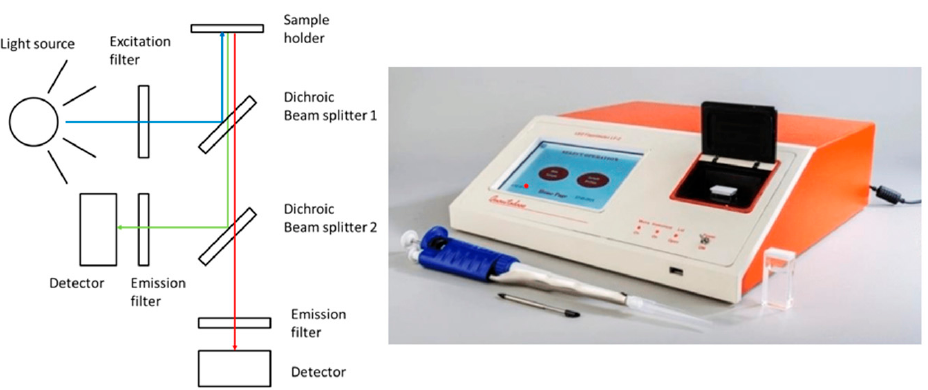
Figure 14. Schematic diagram depicting the working principle and a photo of commercial LED fluorimeter, modified from [117].